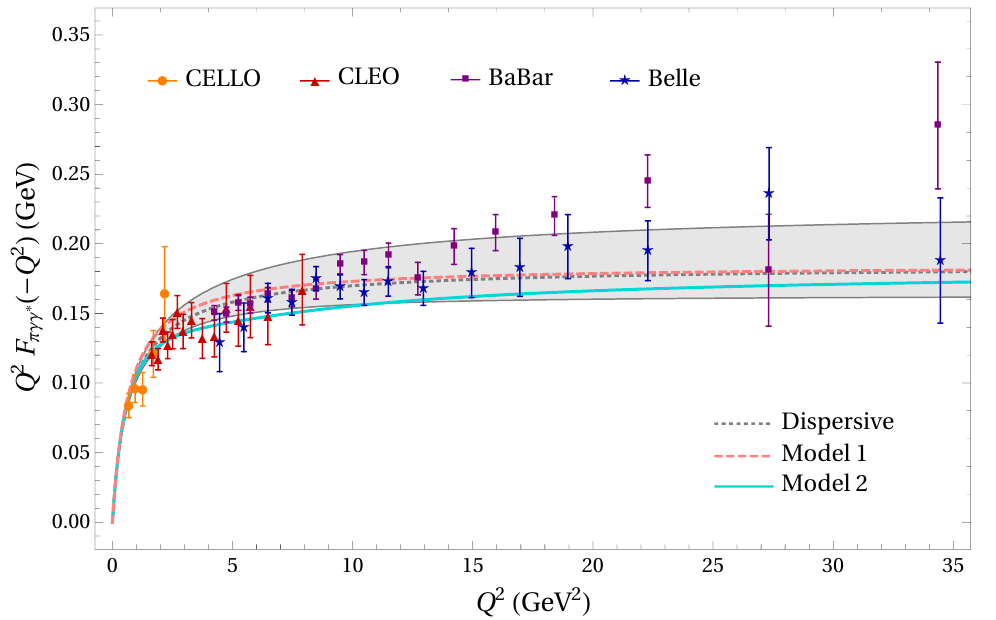
Figure 7. Singly-virtual (cid:25) 0 TFF. The large- N c Regge model, \Model 1" (4.10), is indicated by the dashed pink curve. Our alternative TFF model, \Model 2" (B.1), is indicated by the solid cyan curve. The gray band with the dotted curve is the dispersive result from refs. [46, 47]. The data are from CELLO [115], CLEO [116], BaBar [117], and Belle